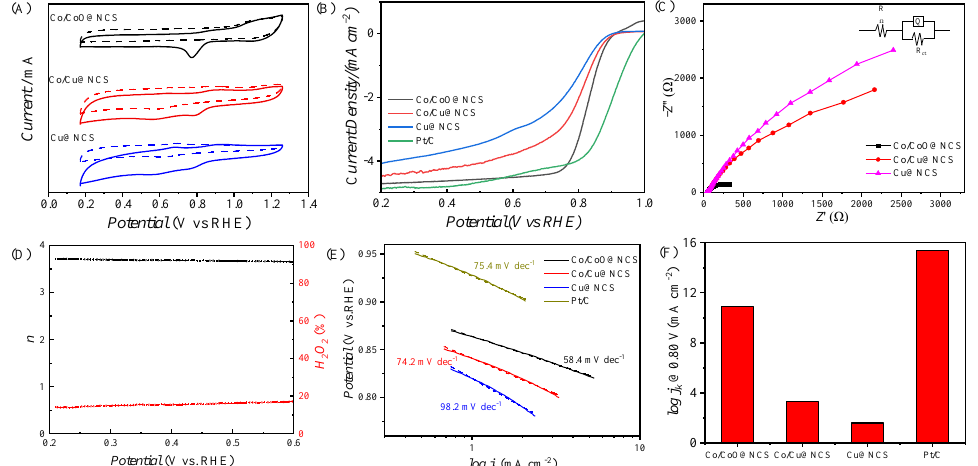
Figure 6. Electrocatalytic activity of M@NCSs for ORR: ( A ) CV curves in nitrogen saturated and oxygen saturated electrolyte, ( B ) LSV curves of M@NCSs and Pt/C, ( C ) EIS spectra of M@NCS, ( D ) electron transfer number and hydrogen peroxide yield of Co/CoO@NCS measured by RRDE, ( E ) Tafel plots, and ( F ) summary of the kinetic current densities of M@NCS and Pt/C at 0.80 V. The Tafel slope curves of M@NCS and Pt/C are shown in Figure 6E. The Co/CoO@NCS